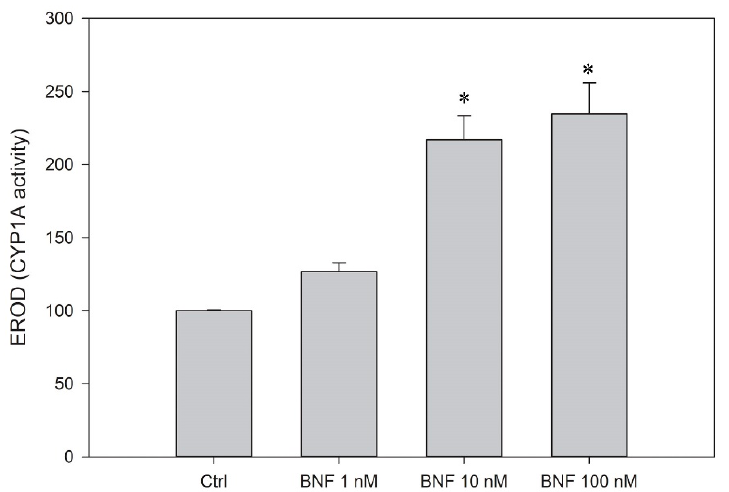
Figure 9. CYP1A induction. The cells were treated with BNF for 24 h and their catalytic activity was measured by the EROD assay. The results represent mean ± SEM of 3 independent experiments. * indicates significantly different from control.